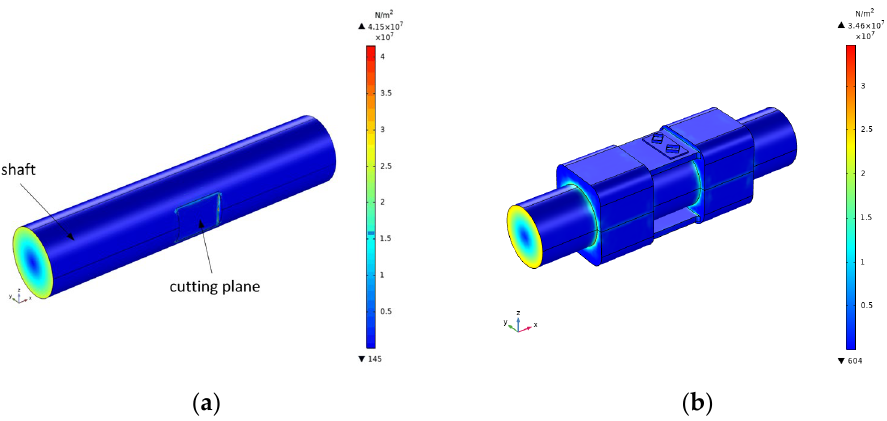
Figure 10. Surface shear stress cloud diagram of SAW torque sensor: ( a ) traditional forms and ( b ) new SAW torque sensor.